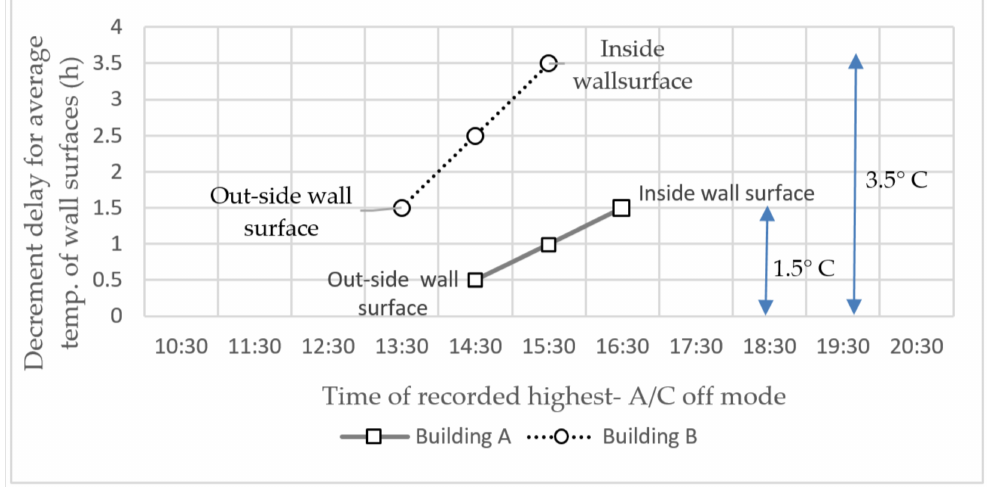
Figure 14. Shorter decrement delay of 1.5 ◦ C with inside wall surface temperature in shallow plan form (Building A) as compared to the larger decrement delay of 3.5 ◦ C with the same in deep plan form (Building